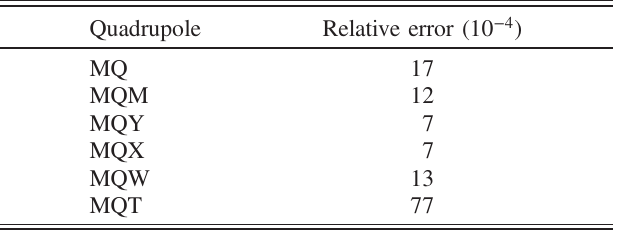
TABLE I. Magnetic errors used in different quadrupoles taking [13] as a reference with a larger relative error in